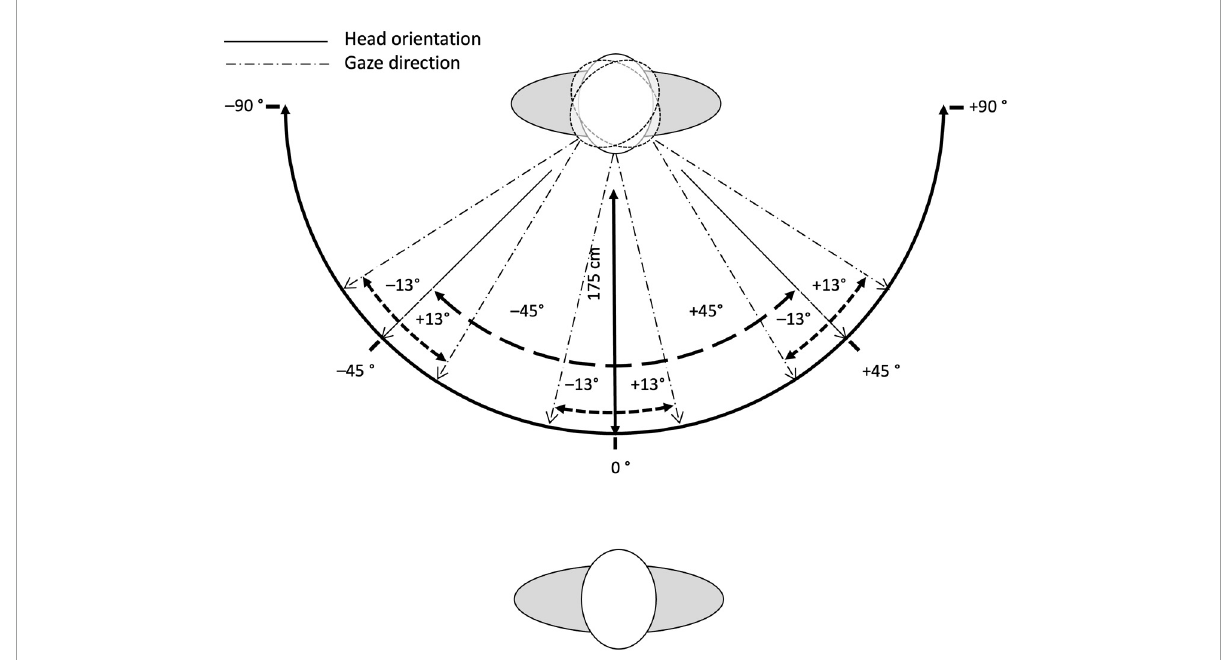
FIGURE1 Schematic illustration of the variation of gaze direction and head orientation. Note that the models changed their gaze direction and facial expression. Head orientation was achieved with synchronized cameras at 0 ◦ , 45 ◦ , and –45 ◦ relative to frontal view.